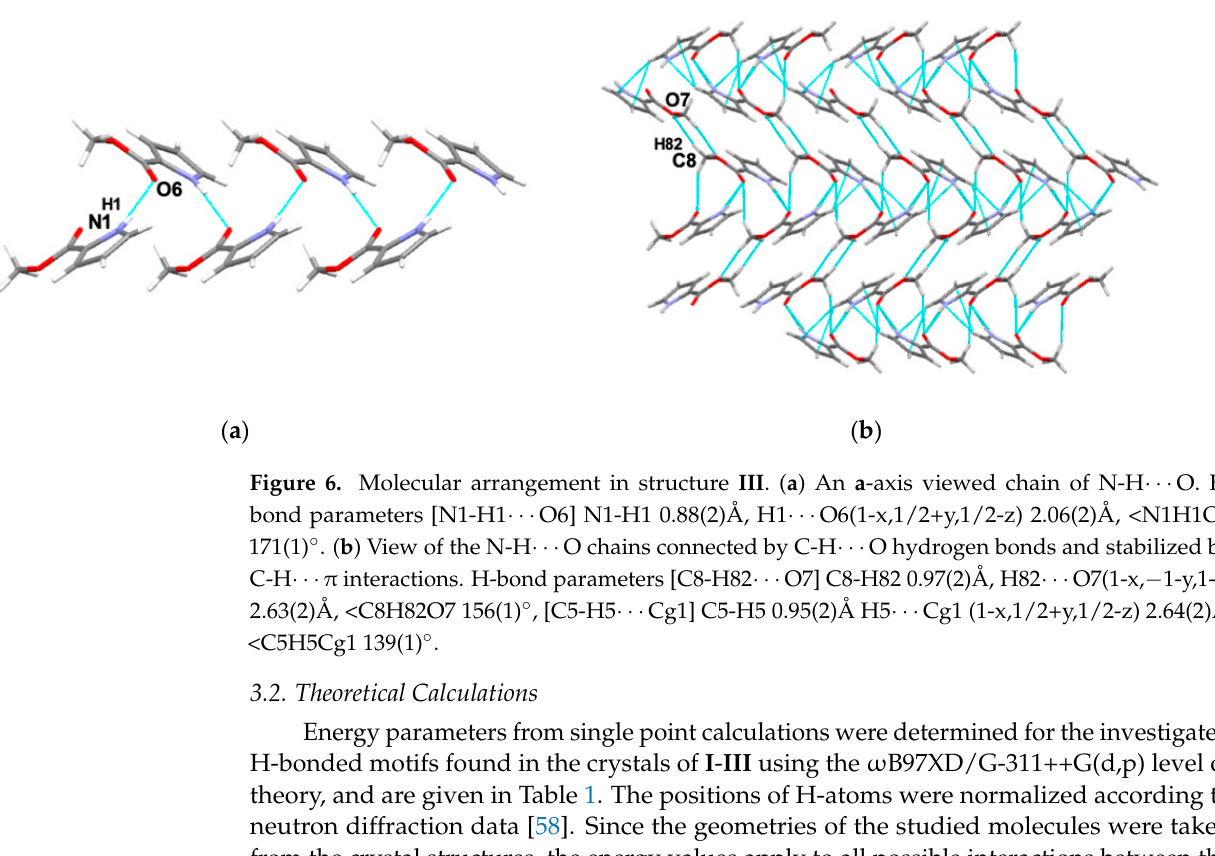
Figure 5. Molecular arrangements in structure II . ( a ) The c -axis view of the chain created by the hydrogen bond N1-H1 ⋯ O6 and ( b ) stabilized by the hydrogen bonds N1-H1 ⋯ Cl8 and C4-H4 ⋯ O6. H-bond parameters [N1-H1 ⋯ O6] N1-H1 0.90(2)Å, H1 ⋯ O6(1/2+x,1/2-y,1-z) 2.05(2)Å, <N1H1O6 164(1)°, [C4-H4 ⋯ O6] C4-H4 0.93(2)Å, H4 ⋯ O6(3/2-x,1-y, − 1/2+z) 2.52(2)Å, <C4H4O6 163(1)°, [N1-H1 ⋯ [N1-H1 · · · Cl8] N1-H1 0.90(2)Å, H1 · · · Cl6( − 1/2+x,1/2-y,1-z) 2.90(2)Å, <N1H1Cl8 126(1) ◦ . ( c ) 3D Cl8] N1-H1 0.90(2)Å, H1 ⋯ Cl6( − 1/2+x,1/2-y,1-z) 2.90(2)Å, <N1H1Cl8 126(1)°. ( c ) 3D arrangement arrangement viewed along the c -axis. Parameters of X · · · Cg interactions [C3-H3 · · · Cg1] C3-H3 viewed along the c -axis. Parameters of X ⋯ Cg interactions [C3-H3 ⋯ Cg1] C3-H3 0.94(2) Å, H3 ⋯ Cg1 (1- 0.94(2) Å, H3 · · · Cg1 (1-x,1/2+y,1/2-z) 2.72(2)Å, <C3H3Cg1 156(1) ◦ . ( d ) 3D arrangement viewed x,1/2+y,1/2-z) 2.72(2)Å, <C3H3Cg1 156(1)°. ( d ) 3D arrangement viewed along the a -axis. along the a -axis.